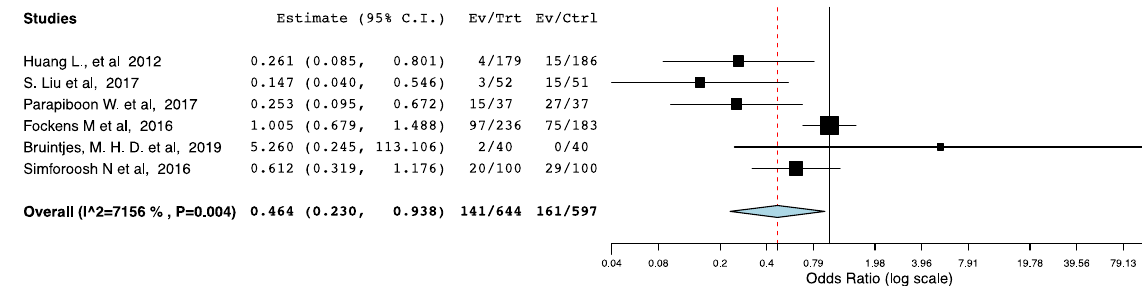
Figure 7. Forest plot: UTIs (ERAS vs. traditional perioperative care).